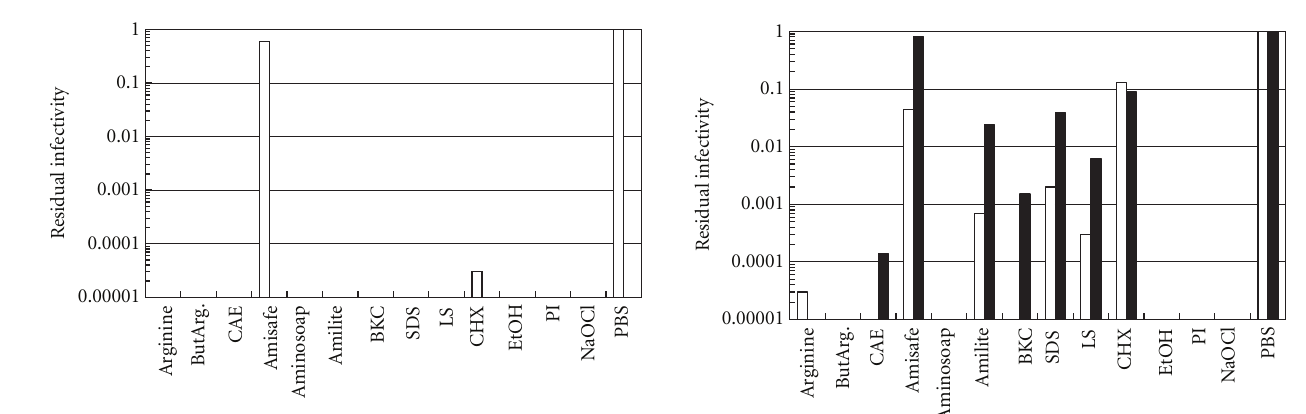
Figure 2: Inactivation of IAV. See the legend to Figure 1. Black and white bars represent the results in the presence or absence of 0.1%